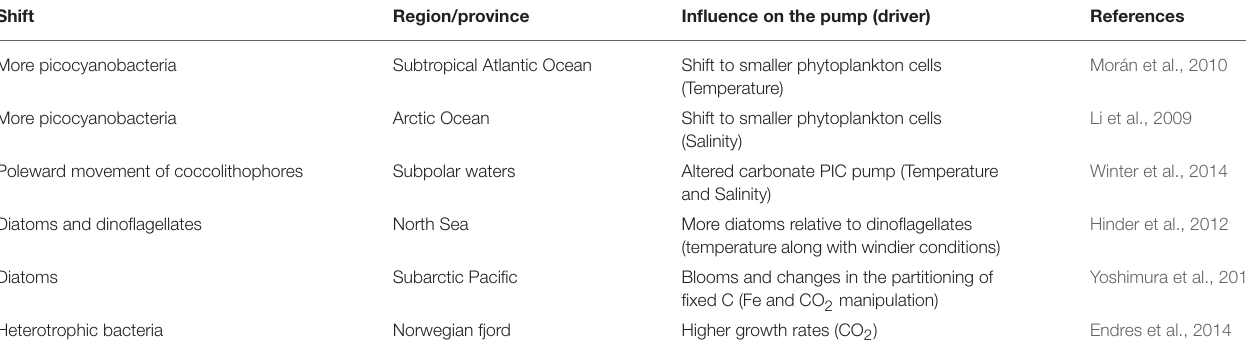
TABLE 4 | Illustrative examples of the wide range of effects on the biological pump due to floristic shifts (see also Review by Boyd et al.,